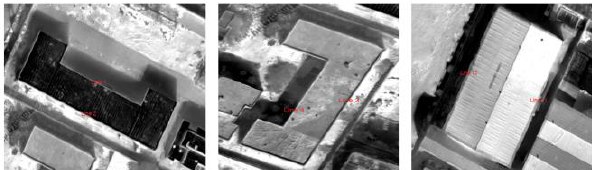
Figure 7. A number of selected buildings to check the accuracy of the extracted edges Figure 8 shows that, line number 23 is not reconstructed well according to the calculated standard deviation value.